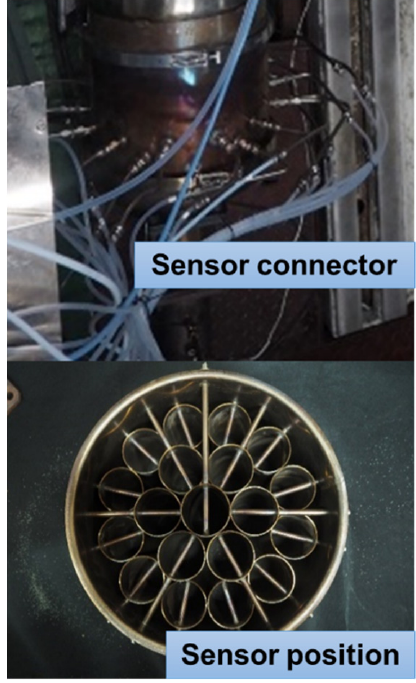
Figure 7. The positions of 19 sensors at the catalyst inlet for the analysis of ammonia uniformity.